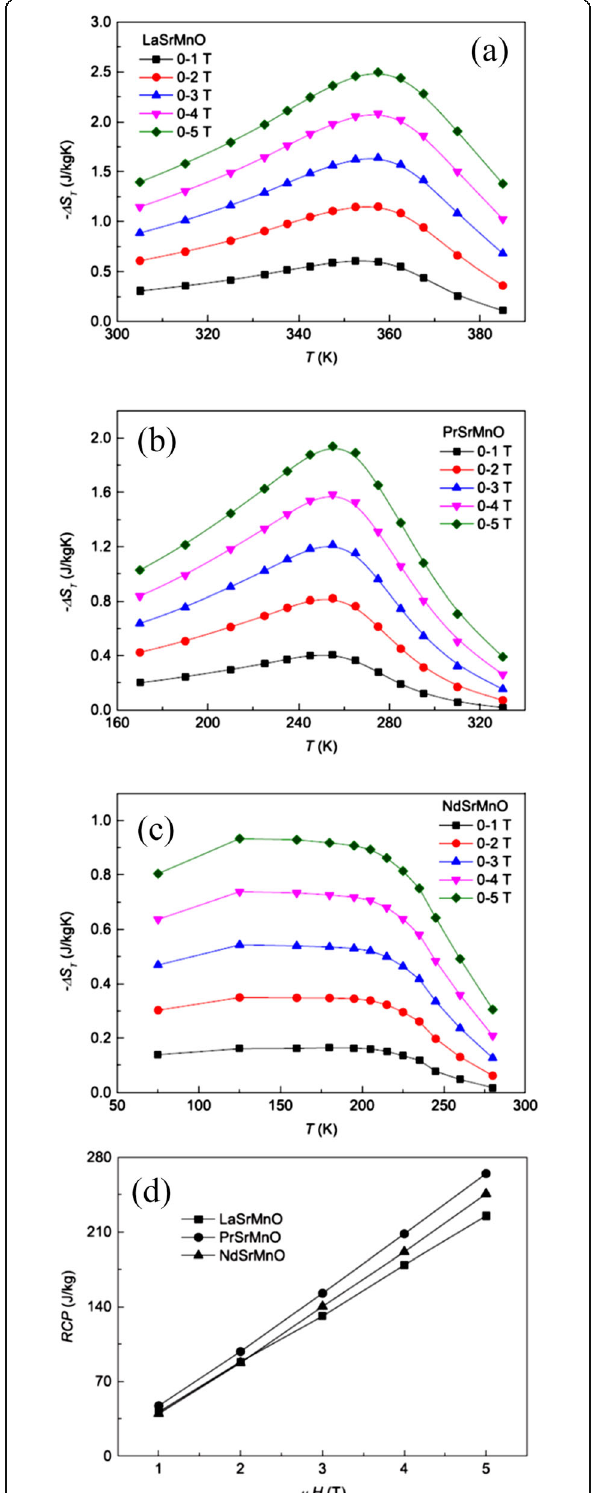
Fig. 22 Isothermal entropy changes as a function of temperature with field changes of 1, 2, 3, 4, and 5 T, a for LaSrMnO 3 , b for PrSrMnO 3 , and c for NdSrMnO 3 , respectively. d Relative cooling power (RCP) as a function of magnetic field for the Ln 0.67 Sr 0.33 MnO 3 (Ln = La, Pr, and Nd) nanocrystalline samples. Reproduced with permission of [38]